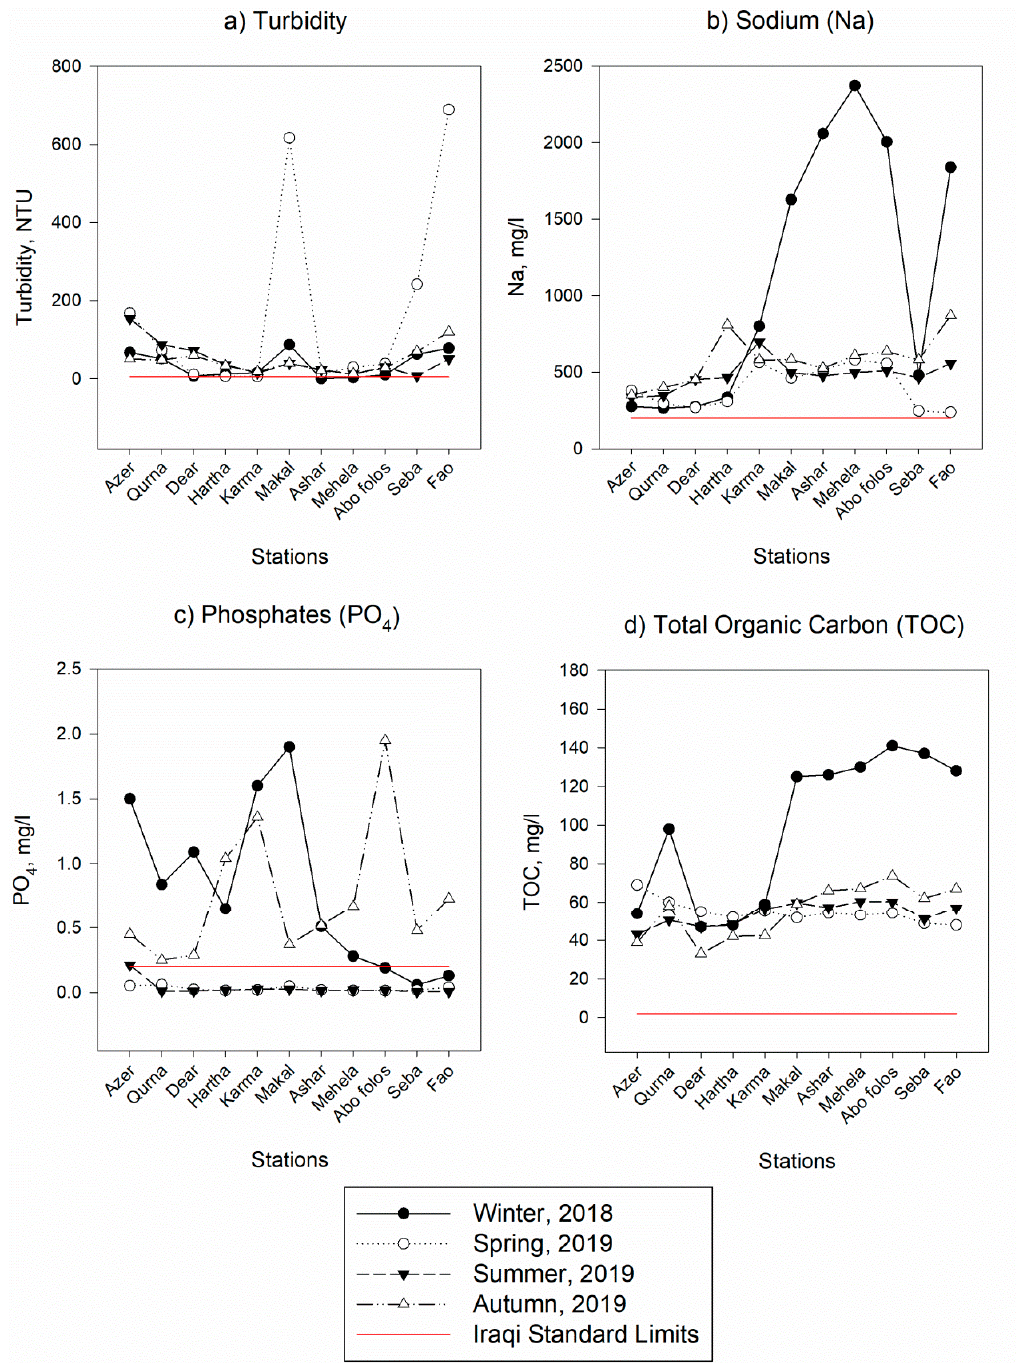
Figure 12. Other water quality parameter concentrations of the selected stations for different seasons during the study period: ( a ) Turbidity, ( b ) Sodium, ( c ) Phosphate, and ( d ) Total Organic Carbon.